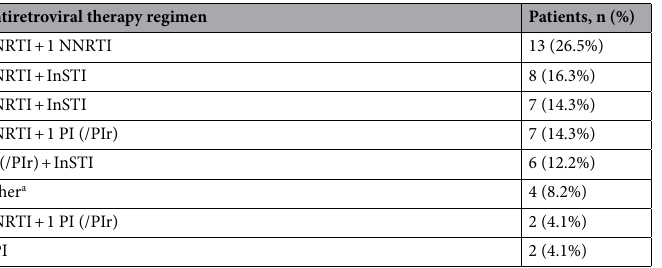
Table 3. Antiretroviral drug regimens ongoing before anti HCV treatment start. For each drug combination are reported the absolute number of patients treated and the percentage respect to the total number of